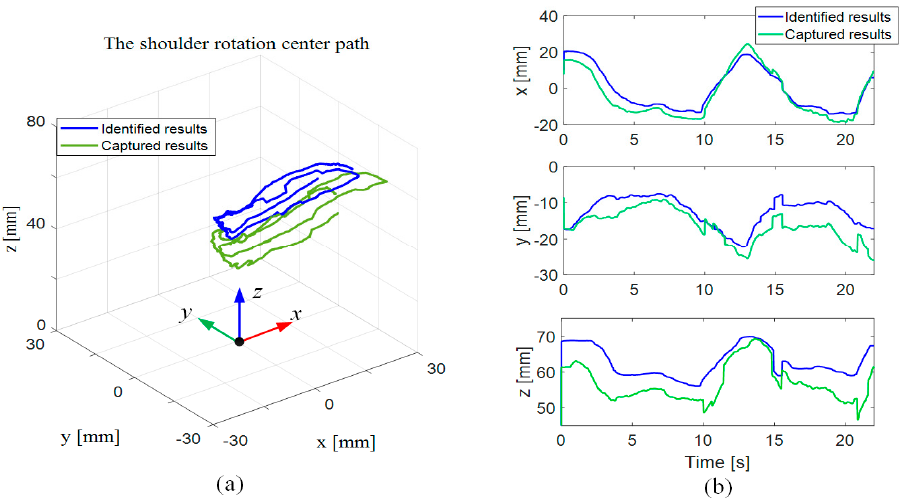
Figure 9. The movement of the shoulder joint center in ( a ) 3D and ( b ) 2D plots.